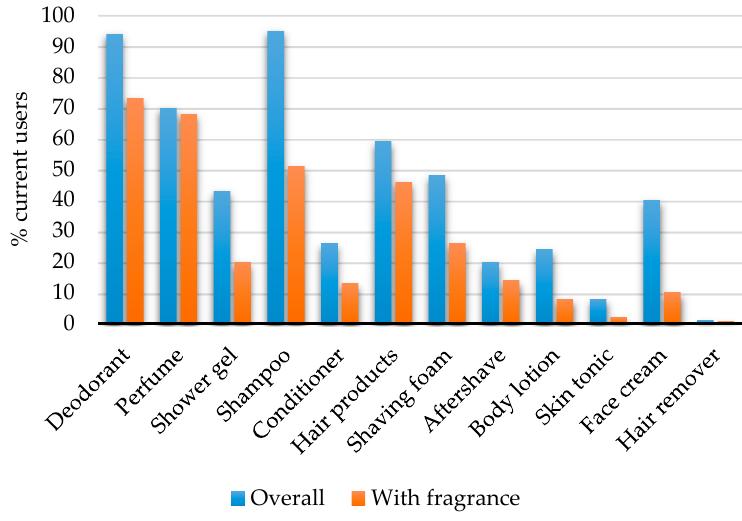
Overall With fragrance Figure1. Percentagesofcurrentusersofpersonalcareproductsamongthe1046menintheFEPOScohort. Figure 1. Percentages of current users of personal care products among the 1046 men in the FEPOS Table 3. Phi coe ffi cients for co-use of PCPs among the 1046 men in the FEPOS cohort. cohort. General Hygiene Hair Care Table 3. Phi coefficients for co-use of PCPs among the 1046 men in the FEPOS cohort. Item Deodorant Perfume Shower Gel Shampoo Conditioner Hair